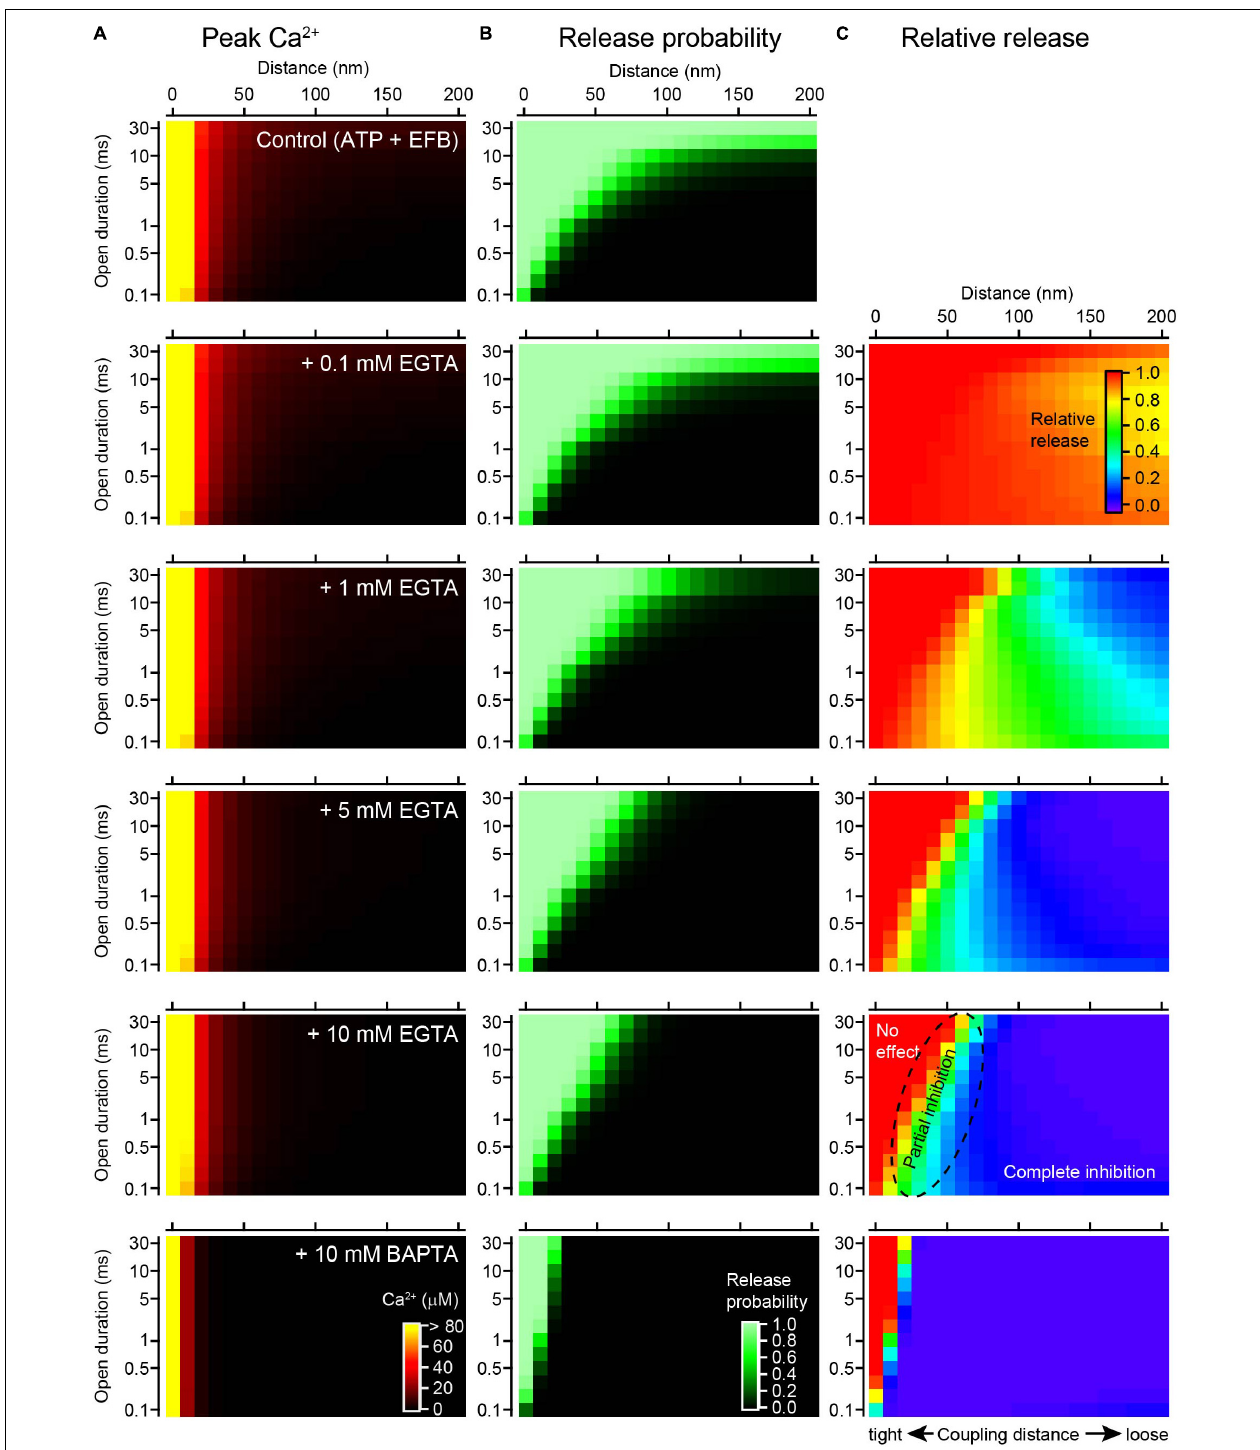
FIGURE 5 | Channel open duration affects the inhibitory effect of EGTA on vesicular release. (A) Spatiotemporal profiles of peak [Ca 2 + ] i in response to a single channel opening under the control condition (0.2 mM ATP + EFB) and with 0.1, 1, 5, and 10 mM EGTA and 10 mM BAPTA (from top to bottom). The amplitude of the single VGCC current was 0.3 pA. Note that [Ca 2 + ] i of > 80 µ M is colored yellow to magnify the concentration gradient near K D of the Ca 2 + sensor. (B) Spatiotemporal profiles of Pvs calculated from Ca 2 + transients in panel (A) using the five-site release model. (C) Spatiotemporal profiles of the inhibitory effect of various chelator concentrations of EGTA and 10 mM BAPTA on Pv. The graph for each chelator condition was calculated from the ratio of Pv in the chelator to that in the control.